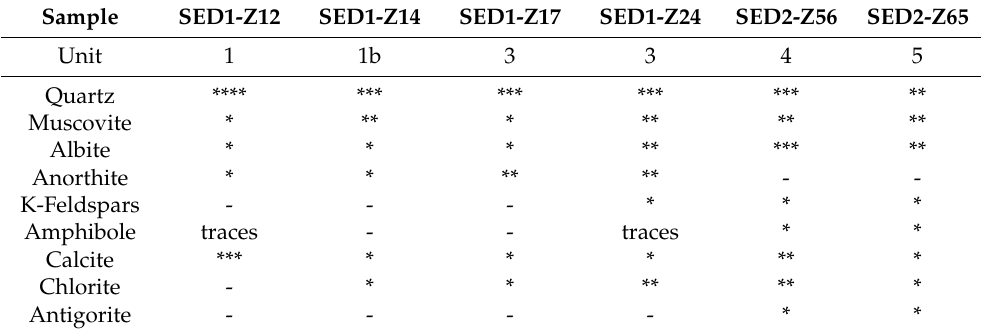
Table 1. Relative abundance of the main minerals in the sediment cores at different depths, obtained from XRD analyses performed on 4 samples from core SI3 and 2 samples from core SV1 (* symbols indicate the relative abundance, ranging from * indicating scarce amount to **** indicating a major abundance). Sedimentological units of all samples are also reported. See Figure 2 for core location and stratigraphy of the sampled cores. Refer to Figure S1 in Supplementary Materials for XRD